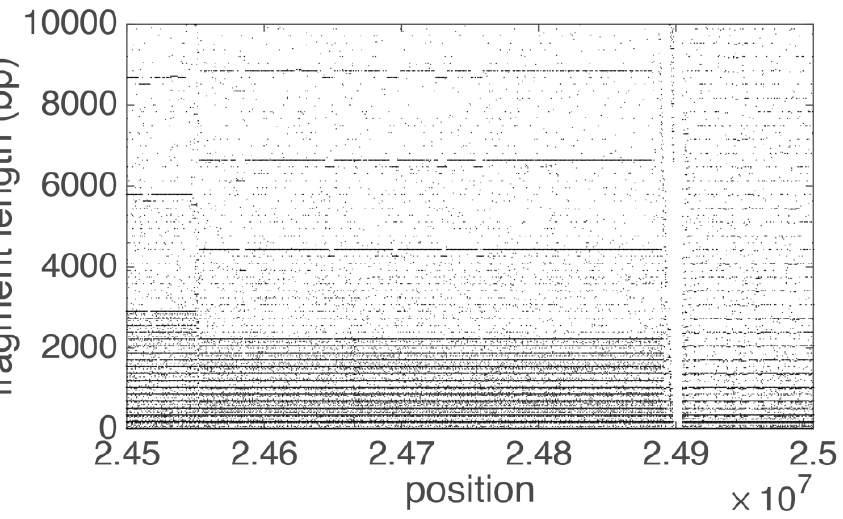
Figure 6. Fragment diagram for part of centromeric region of human chromosome 19. Each dot in the Fragment diagram corresponds to the fragment length (component a i of vector a i ) at that position (component a i of vector a i ) . On the left side of the diagram the alpha satellite monomers are organized in 17 mer HOR (2896: 171 ≈ 17) structures, in the middle in 13 mer HOR (2216: 171 ≈ 13) structures and on the left in tandem monomeric arrays without any HOR structures.